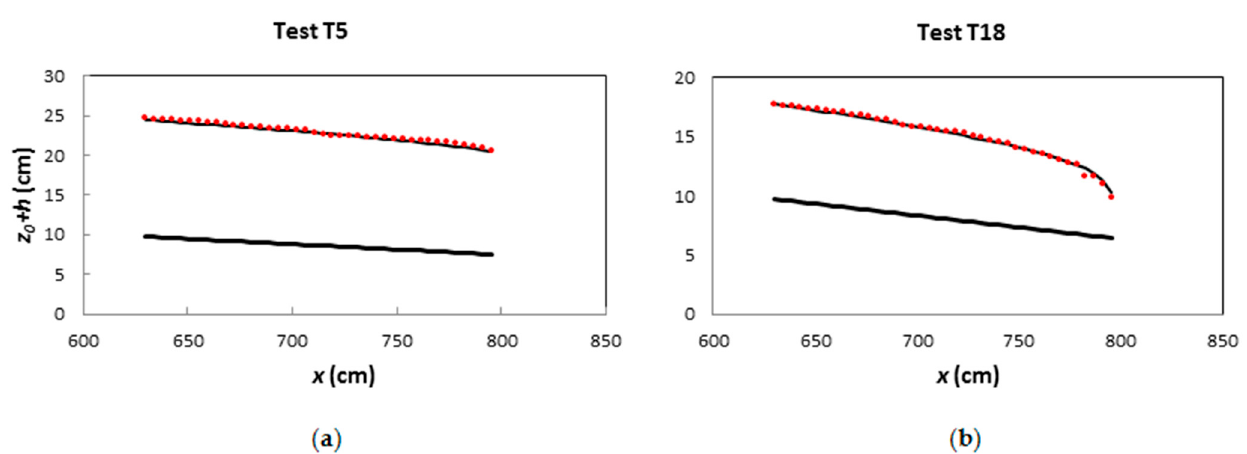
Figure 4. Comparison between the measured flow depth and the fitted logarithmic function [1]: ( a ) T5; ( b ) T18. The black bold line indicates the flume bottom; the black line is the calculated free surface; the red symbols indicate the measured free surface.